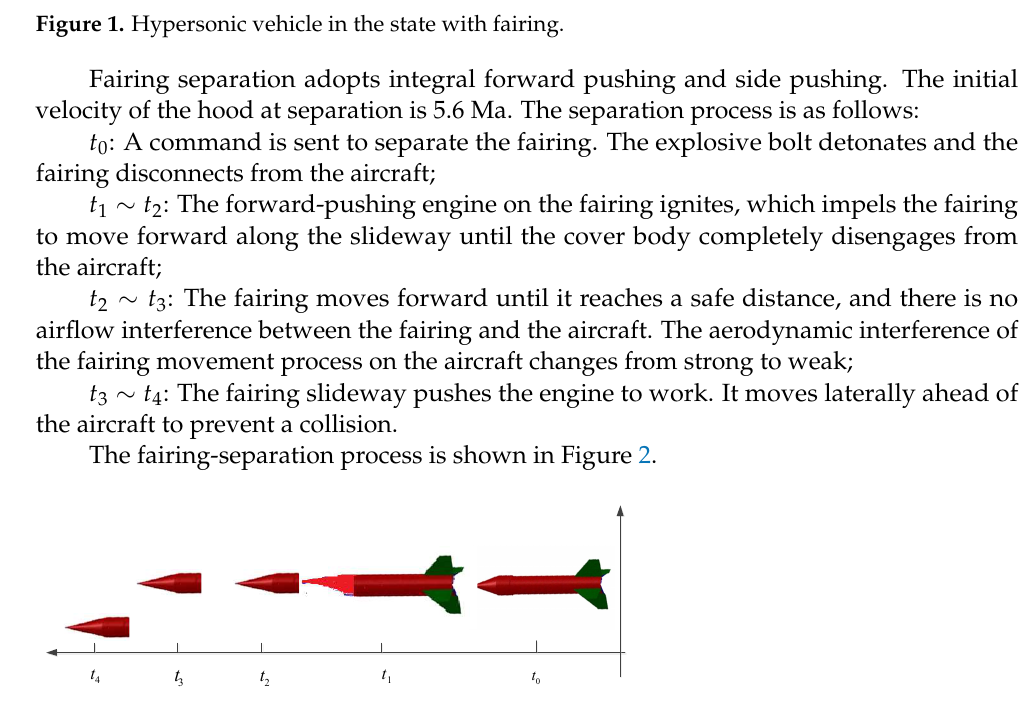
Figure 2. Schematic diagram of the fairing-separation process.